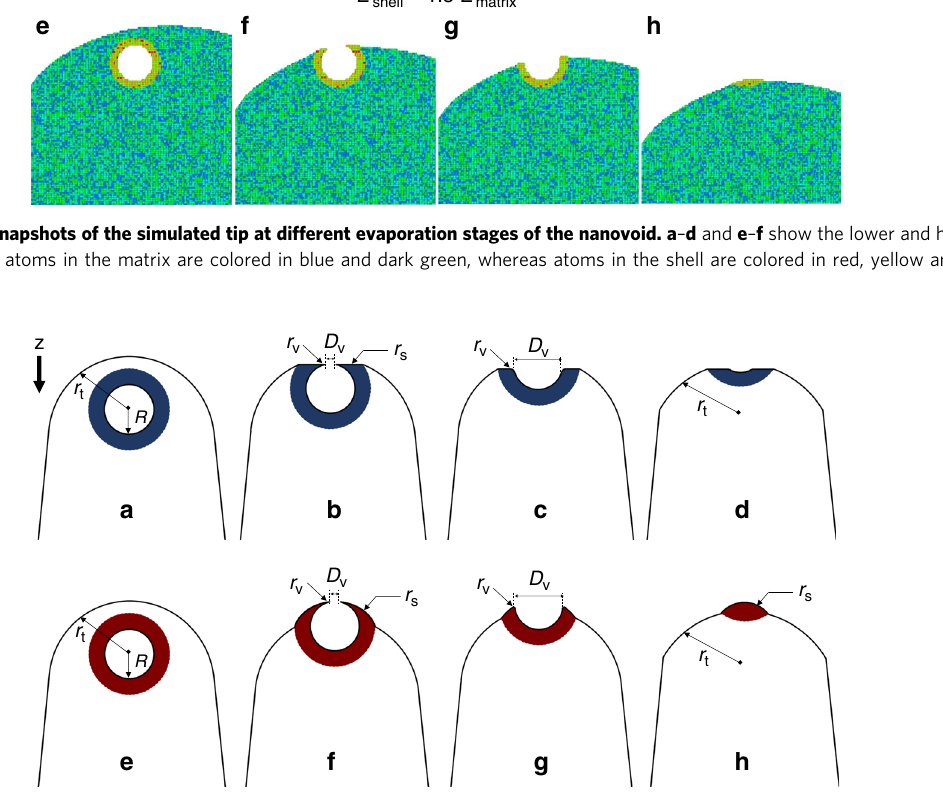
Fig. 6 Schematic showing shape evolution of an APT tip near a void during the evaporation process. a – d show a void with a lower evaporation- fi eld shell colored in blue; e – h show a void with a higher evaporation- fi eld shell colored in red.